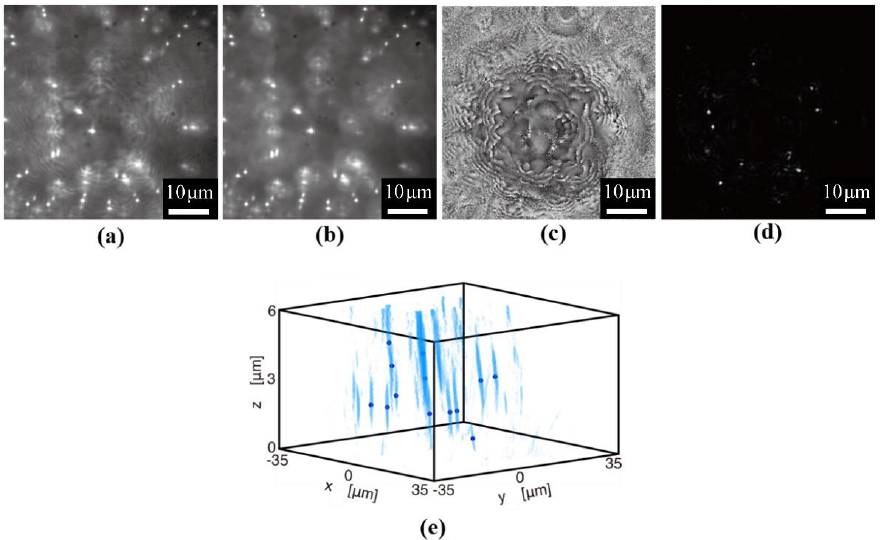
Figure 6. Experimental results of fluorescence holography. ( a ) One of the phase-shifted holograms, ( b ) intensity, and ( c ) phase distributions on the image sensor plane. ( d ) Reconstructed image on a specified depth, and ( e ) three-dimensional (3D) mapping of fluorescent nanoparticles with incoherent digital holographic microscopy.